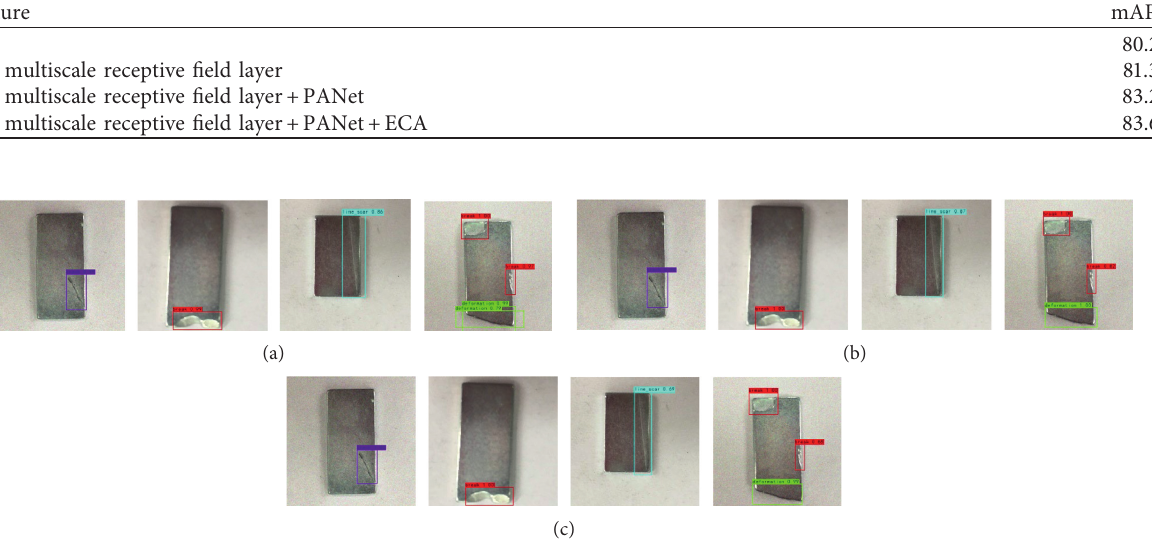
Figure 11: The detection effect of SSD algorithm on large-size defects before and after improvement. (a) Detection effect of MobileNetV2- SSD. (b) Detection effect of original SSD. (c) Detection effect of improved